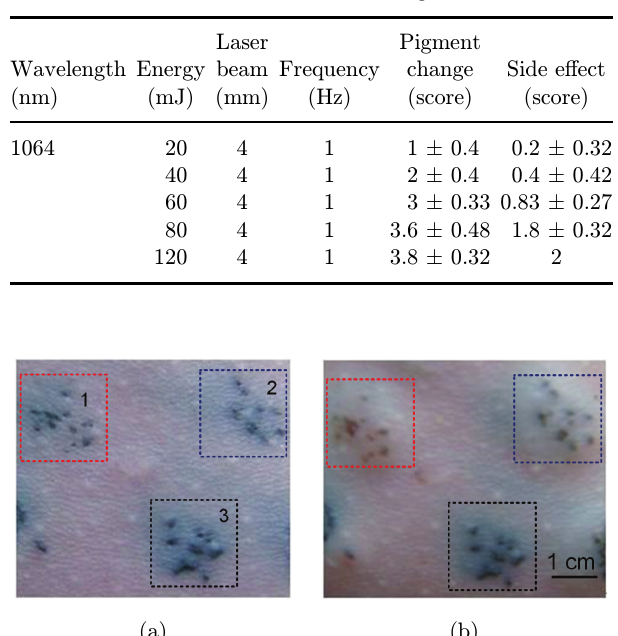
Table 2. Score scale of tattoo pigment change and side e®ects of laser tattoo removal with di®erent energies.